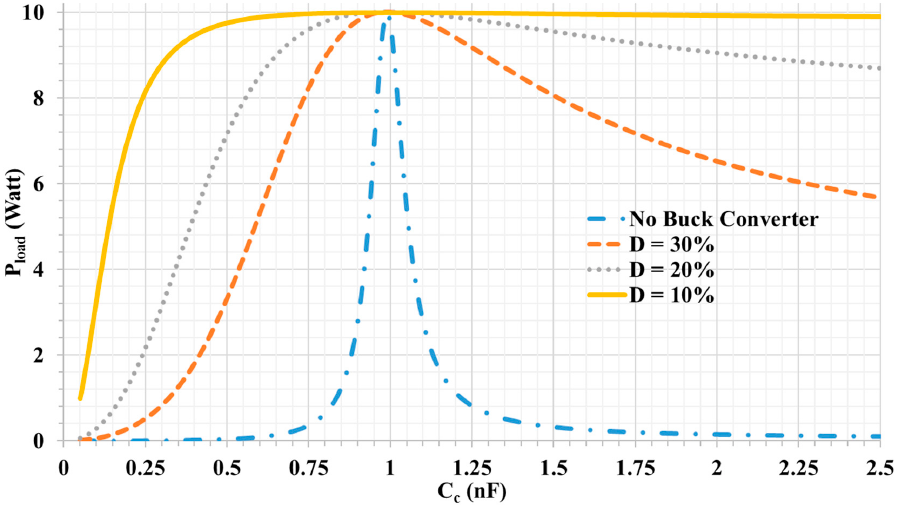
Figure 5. The tolerance of the output power with the change in the capacitive interface value using different duty cycles D .